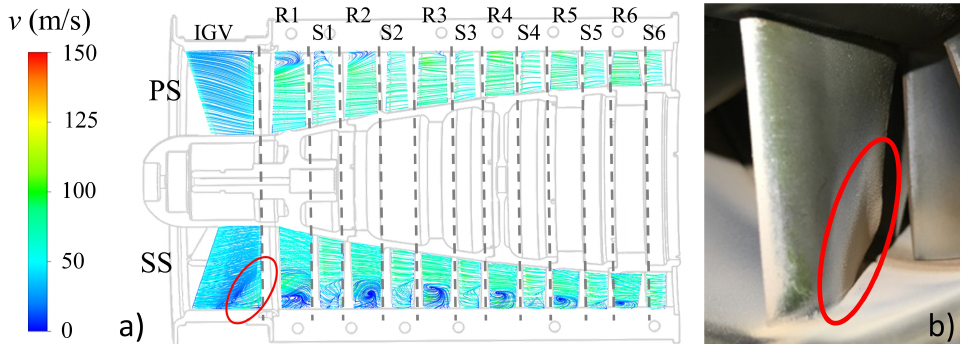
Figure 10. Surface streamlines on the airfoils over the compressor flow-path ( a ) and the SS of the compressor IGV with the separation zone highlighted ( b ).